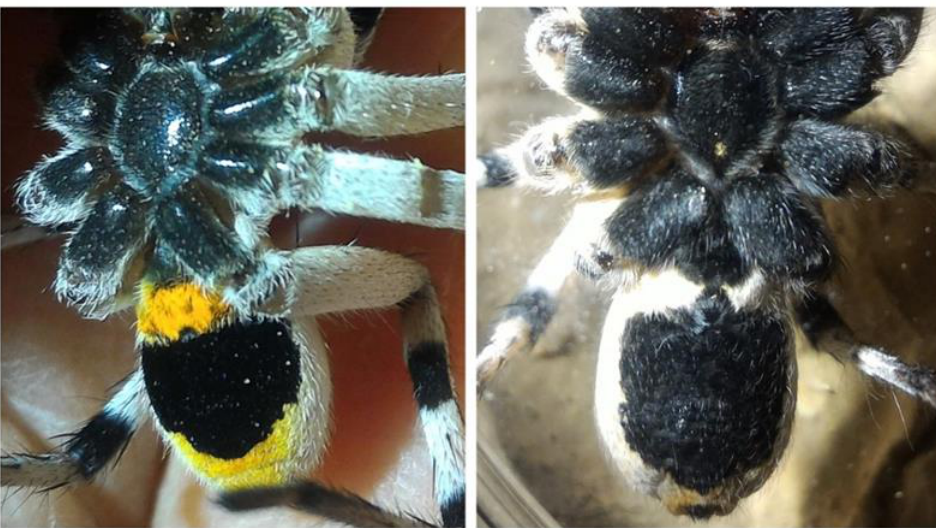
Figure 1. Morphological differences between the spiders, Lycosa olivieri and “ L. hyraculus" . The two spiders can be distinguished by the coloration on the abdomen of subadults and adults, as well as by their burrow structure. L. olivieri ( left ) often builds a grass turret around its burrow entrance and has extensive orange coloration on its abdomen, whereas the trapdoor-building “ L. hyraculus" ( right ) is only orange around its spinnerets.